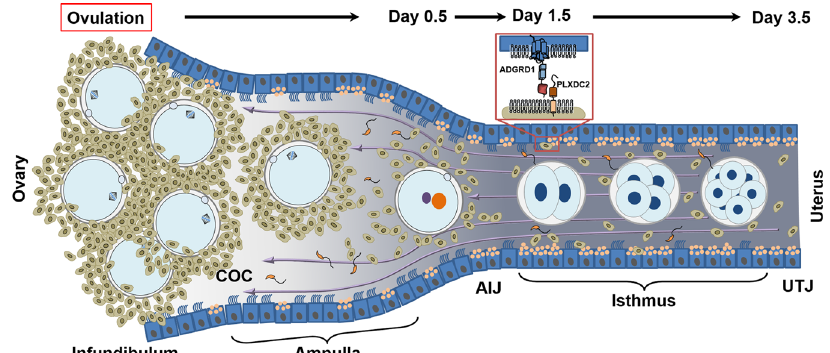
Fig. 6 Model describing Adgrd1-mediated control of fl uid fl ow underlies the valve-like behaviour of the mammalian oviduct. Cumulus-oocyte- complexes are ovulated into the infundibulum and rapidly transported to the AIJ by the action of the cilia lining the oviductal epithelium beating towards the uterus. At the AIJ, the COCs are halted due to the balance of abovarial ciliary action and the force of adovarial oviductal fl uid fl ow (purple arrows). In wild-type oviducts, the gradual release of cumulus cells as the hyaluronic acid matrix which surrounds them slowly disintegrates releases the Plxdc2 ligand and triggers a reduction of oviductal fl uid production by activating Adgrd1 on the oviductal epithelium to licence embryo release. COC = cumulus-oocyte- complex; AIJ = ampullary-isthmic junction; UTJ =